Question: In a single sentence, describe what this figure presents.
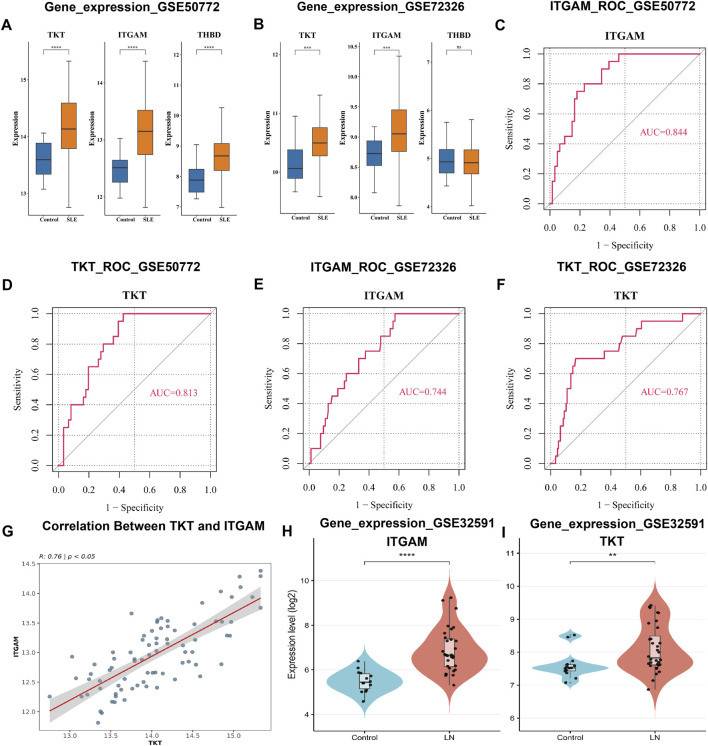
Answer: Validation of ITGAM and TKT in peripheral blood SLE cohorts and human LN renal biopsy tissue. (A,B) Boxplots showed significant upregulation of ITGAM and TKT in SLE samples compared to control samples across both the training and validation cohorts. (C–F) Receiver operating characteristic (ROC) curves illustrated the robust diagnostic performance of ITGAM and TKT, with AUC values exceeding 0.7 in both cohorts, highlighting their capacity to distinguish SLE from control samples (G) Scatter plot showed a significant positive correlation between ITGAM and TKT expression levels (R = 0.76, p < 0.05). (H,I) Violin plots with embedded boxplots showing the expression levels of ITGAM and TKT in control glomerular samples (n = 14) and LN glomerular samples (n = 32) from the human LN renal biopsy dataset GSE32591 . ITGAM and TKT were both significantly increased in LN glomerular samples compared with controls, further supporting their relevance to renal involvement in LN. Statistical significance is indicated as follows: ns, not significant; **p < 0.01; ***p < 0.001; and ****p < 0.0001.